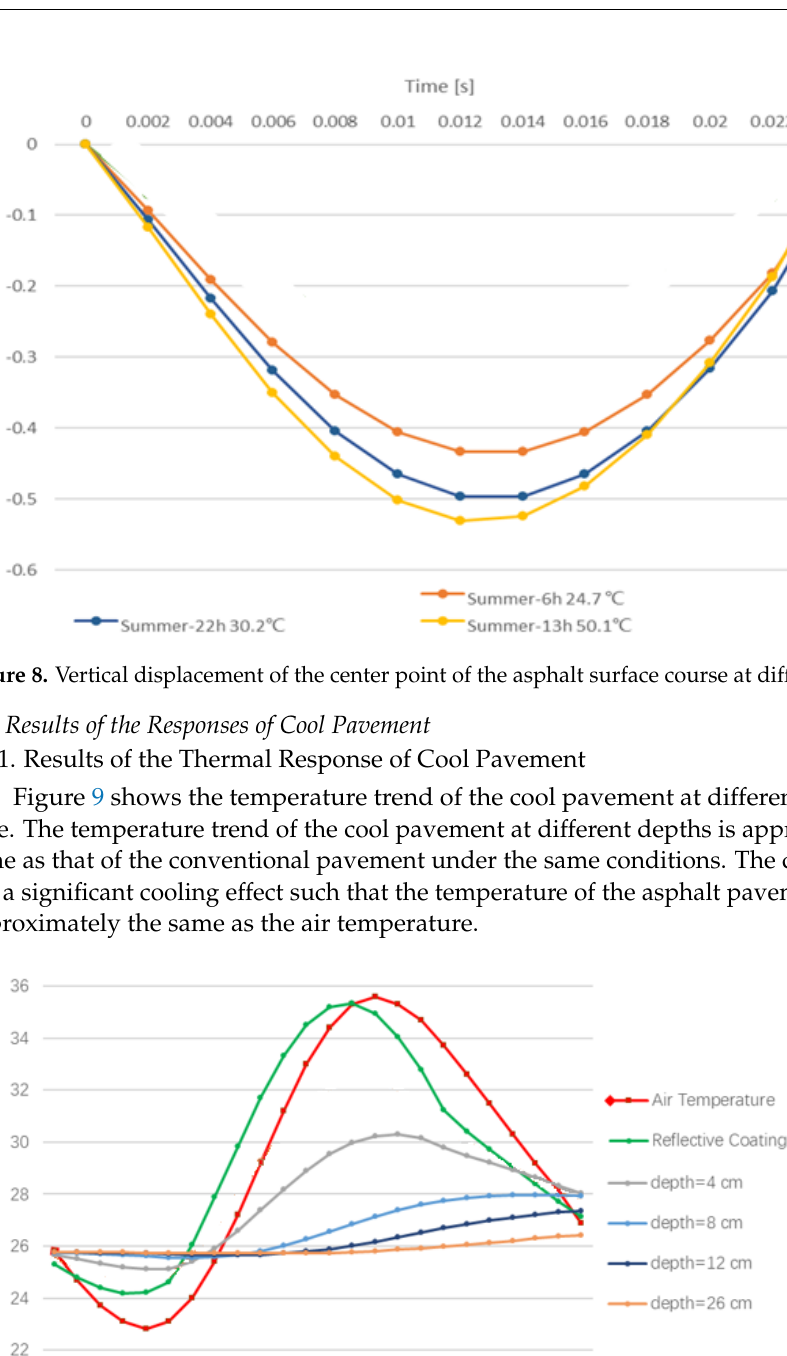
11 of 15 Figure 7. Distribution of the vertical displacement at different moments: ( a ) 6 h, 24.7 °C; ( b ) 22 h, 30.2 °C; and ( c ) 13 h, 50.1 °C. It can be seen from Figure 7 that under the influence of different temperatures, the vertical displacement of the pavement under the same load is obviously different. Figure 8 shows the time-dependent variation of the vertical displacement of the center point in the loading area of the pavement surface. The vertical displacement increases with in- creasing load at the beginning and reaches a peak at 0.012 s. Immediately afterward, the vertical displacement again gradually decreases to 0 as the load is gradually removed. The change of vertical displacement with time is consistent with the change of the applied load. It can be seen that although the surface temperature difference between 6 h (24.7 °C) and 22 h (30.2 °C) is less than 6 °C, the difference in the vertical displacement is much larger than that between 22 h (30.2 °C) and 13 h (50.1 °C). The main reason is that the temperature distribution along the pavement depth is different in the morning than it is at night. At night, the maximum temperature of the road structure appears in the bottom of the asphalt surface course, while the maximum temperature of the daytime structure always appears on the surface of the pavement, which can be seen in Figure 5. This differ- ence in temperature distribution leads to changes in structure stiffness, resulting in signif- icant differences in vertical displacement. It is worth mentioning that the computational mechanical responses were derived from the pavement structures (conventional pave-